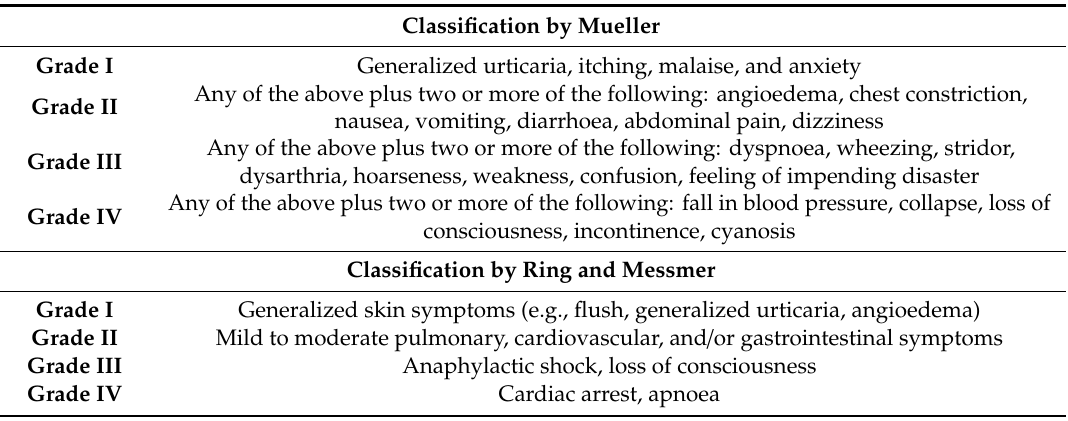
Table 1. Classification of anaphylaxis severity